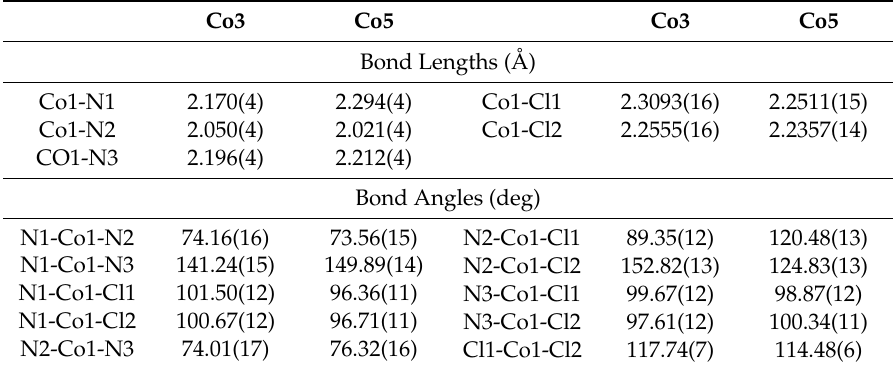
Figure 1. ORTEP drawing of Co3 ( a ) and Co5 ( b ) with thermal ellipsoids at the 30% probability level. Hydrogen atoms are omitted for clarity. Table 1. Selected bond lengths and angles for Co3 and Co5.